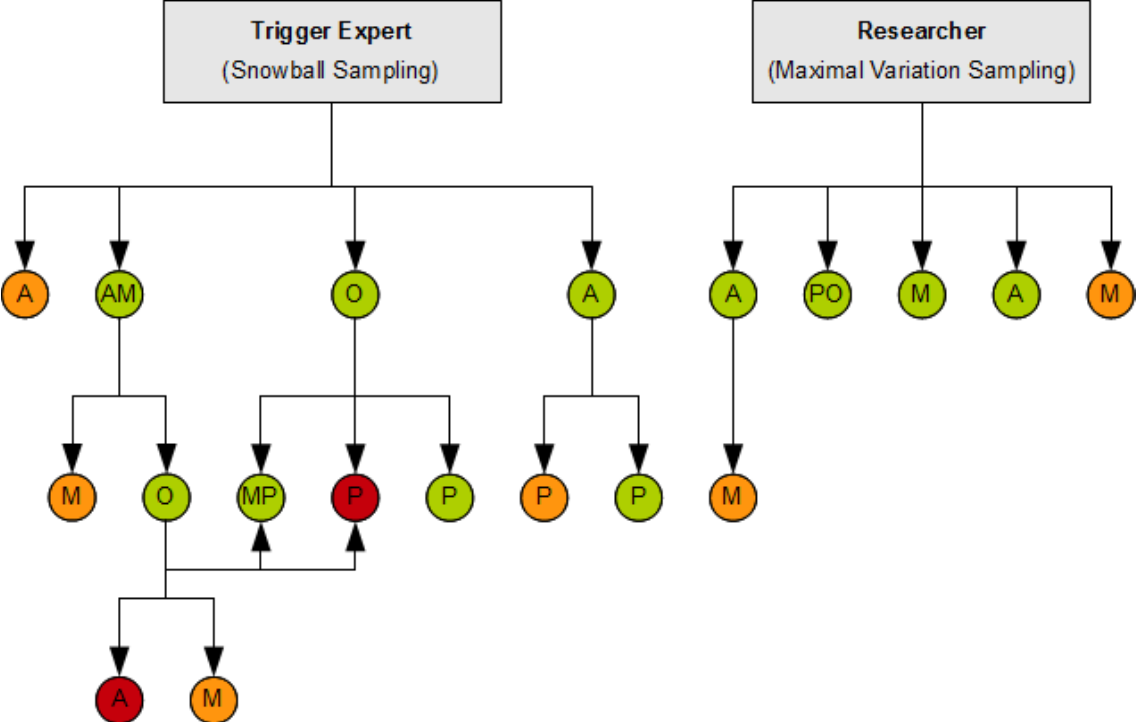
Figure A1 Snowball and maximum variation sampling